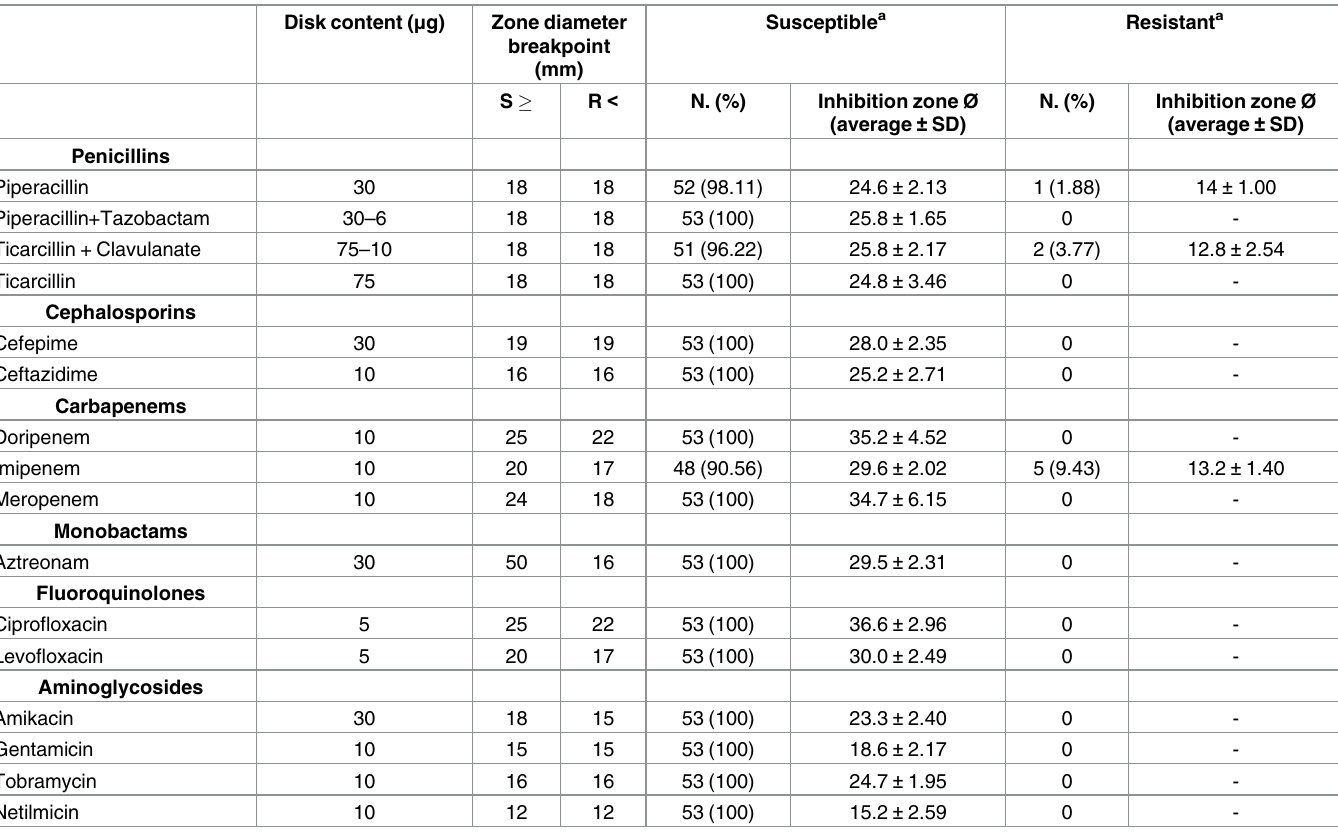
Table 3. Results of susceptibility testing of Pseudomonas aeruginosa (n = 53 isolates) of each antibiotic